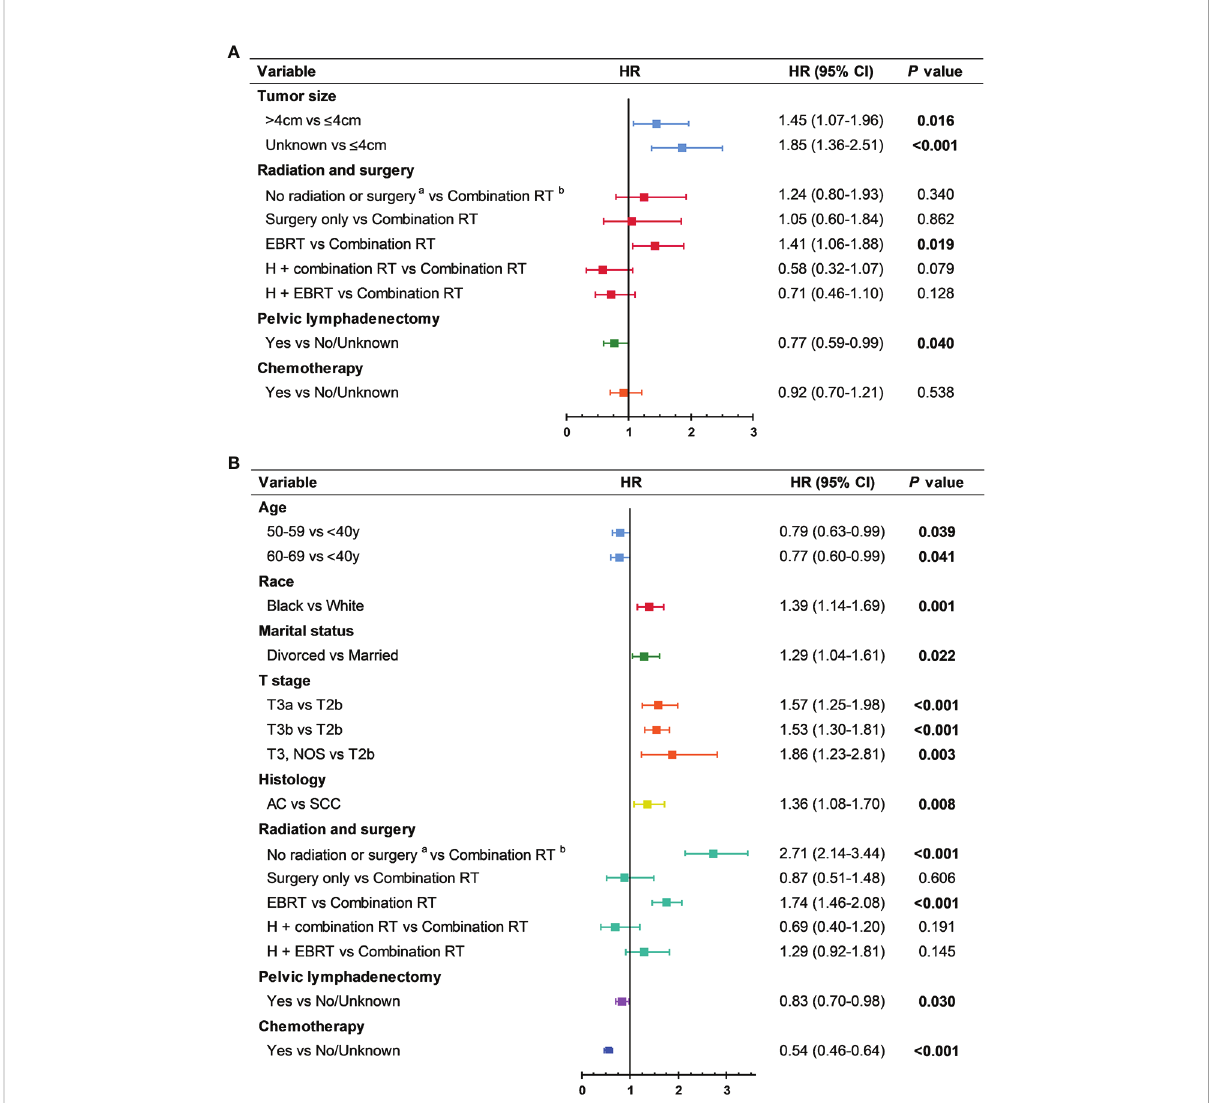
FIGURE 4 Prognostic factors of patients with distant lymph node metastasis. (A) T1-T2a and distant lymph node metastasis. Chemotherapy was forced into the multivariable model. (B) T2b-T3 and distant lymph node metastasis. AC, adenocarcinoma; CI, con fi dence interval; EBRT, external beam radiotherapy; H, hysterectomy; HR, multivariable adjusted hazard ratio; RT, radiotherapy; SCC, squamous cell